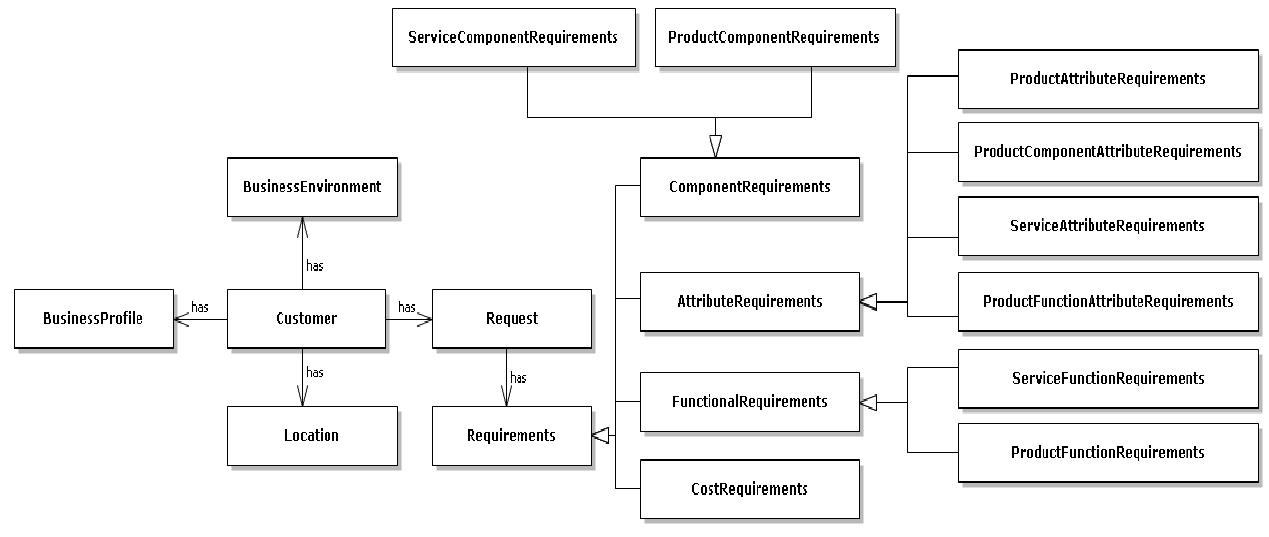
Figure 1. The customer blueprint.